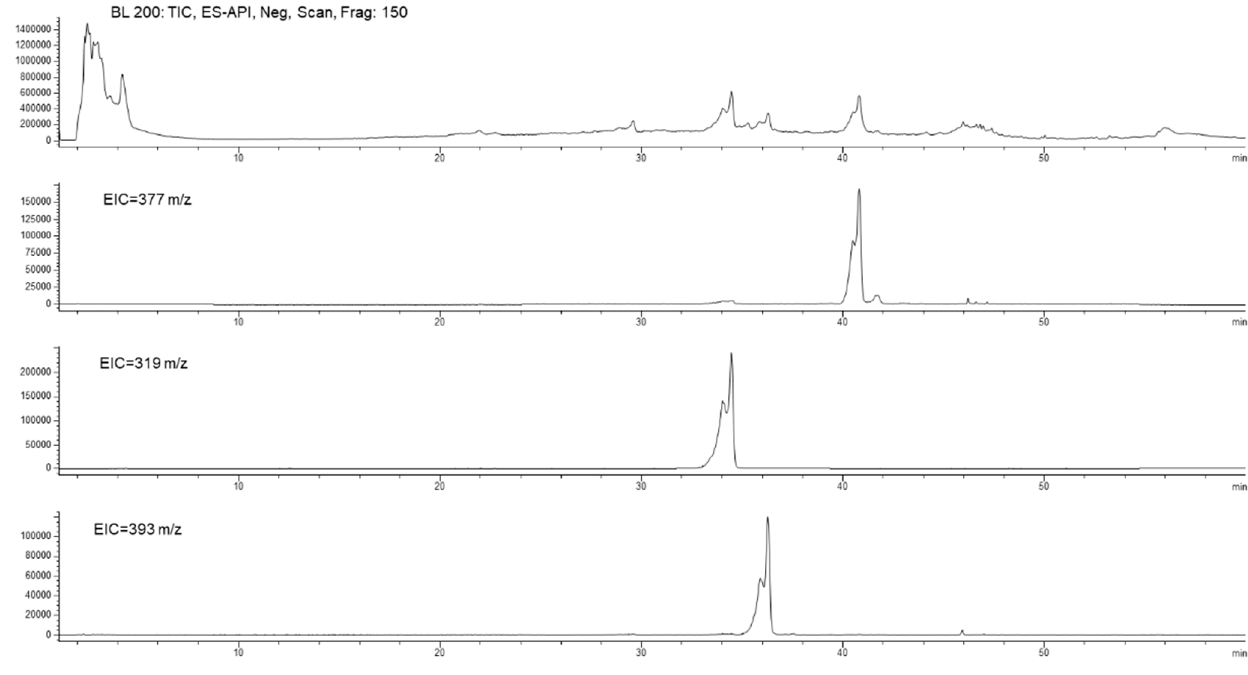
Figure 9. Chromatographic profiles of the BL sample after incubation for 2 h of 200 µg/mL BUO extract in the AP side of Caco-2 cells with, from top to bottom: TIC, EIC at 377 m/z , EIC at 319 m/z , and EIC at 393 m/z .